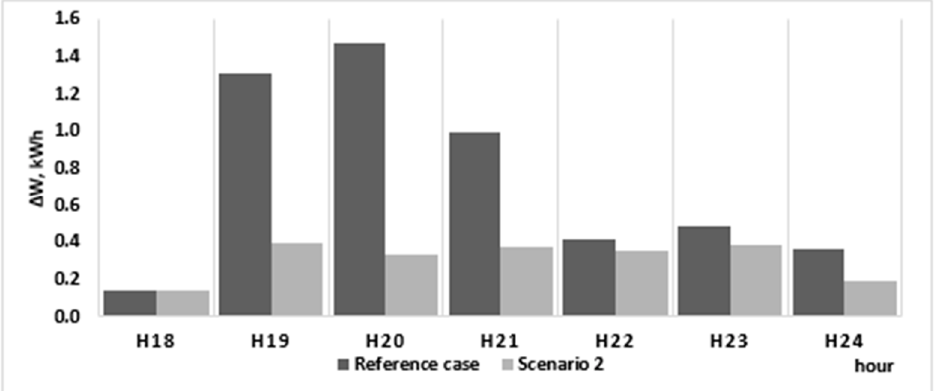
Figure 11. The energy loss reduction at peak hours, Scenario 2.